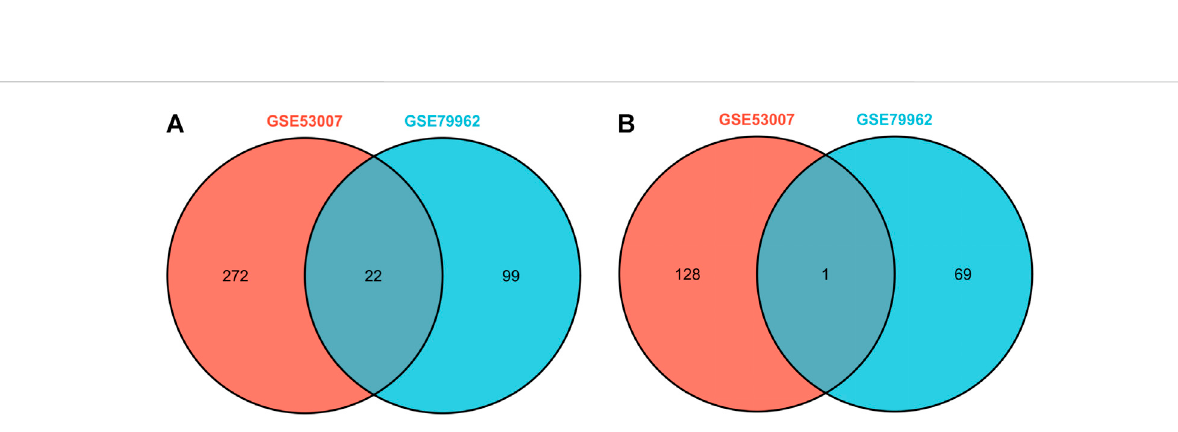
FIGURE 2 VenndiagramofoverlappingupregulatedDEGsofGSE53007andGSE79962. (A) TwodatasetsoverlappingupregulatedDEGs. (B) Twodatasets overlapping downregulated